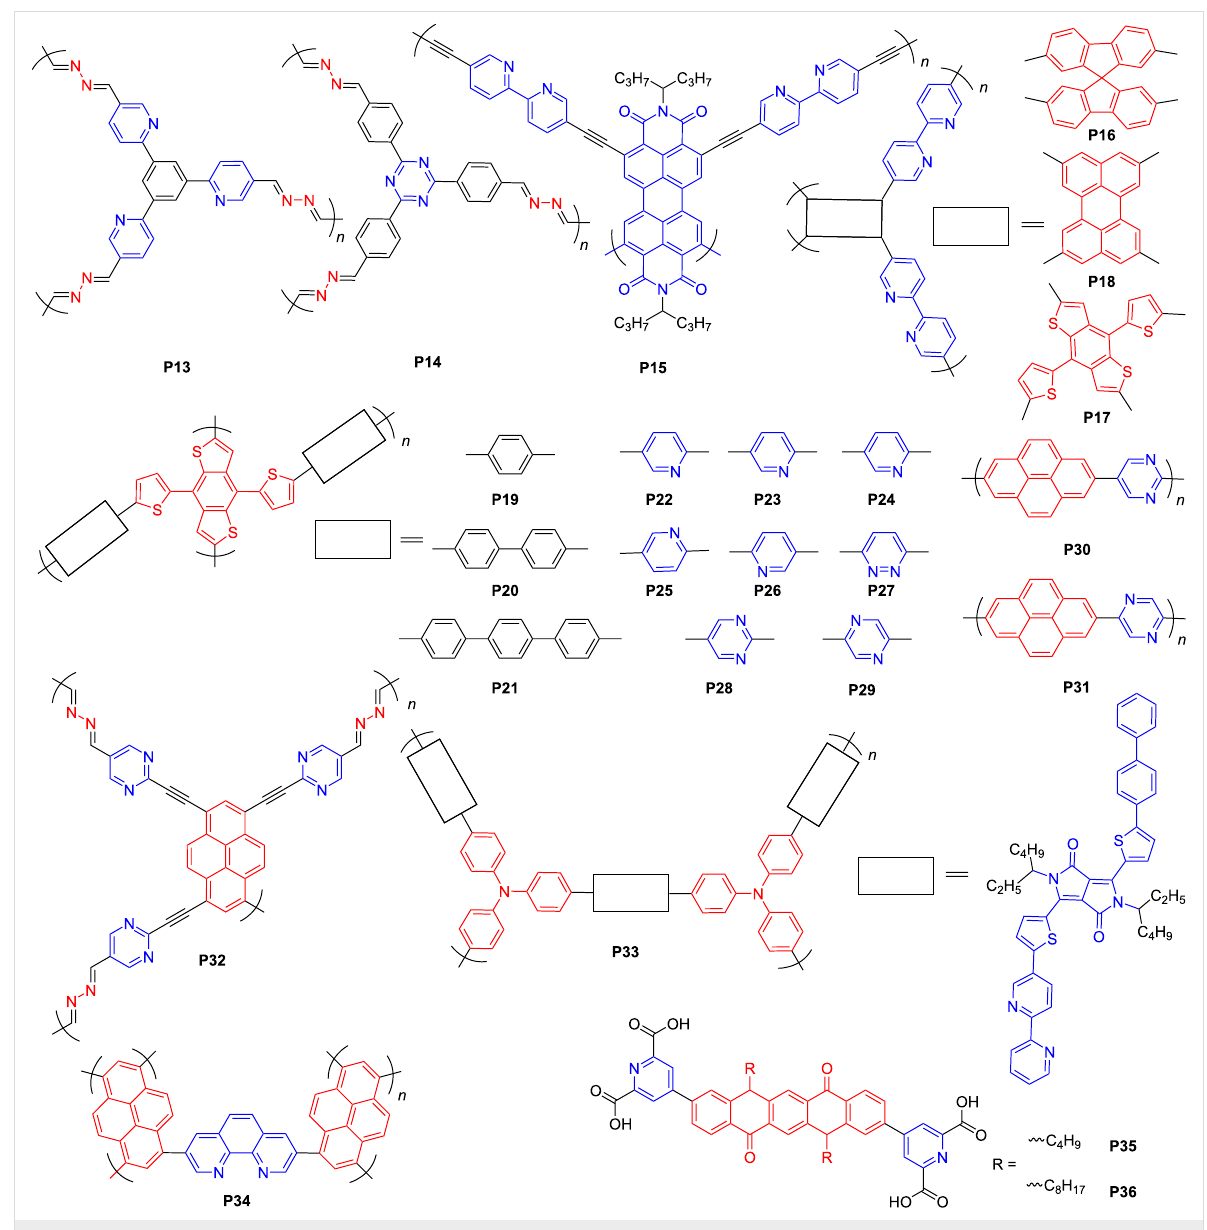
Figure 4: Schematic representation of structures of pyridine-contained conjugated